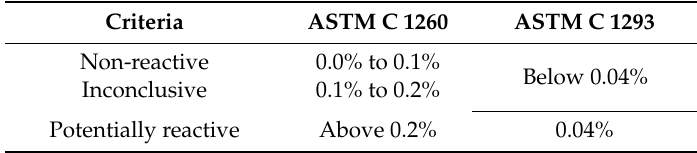
Table 4. Expansion criteria according to ASTM C 1260 and ASTM C 1293.